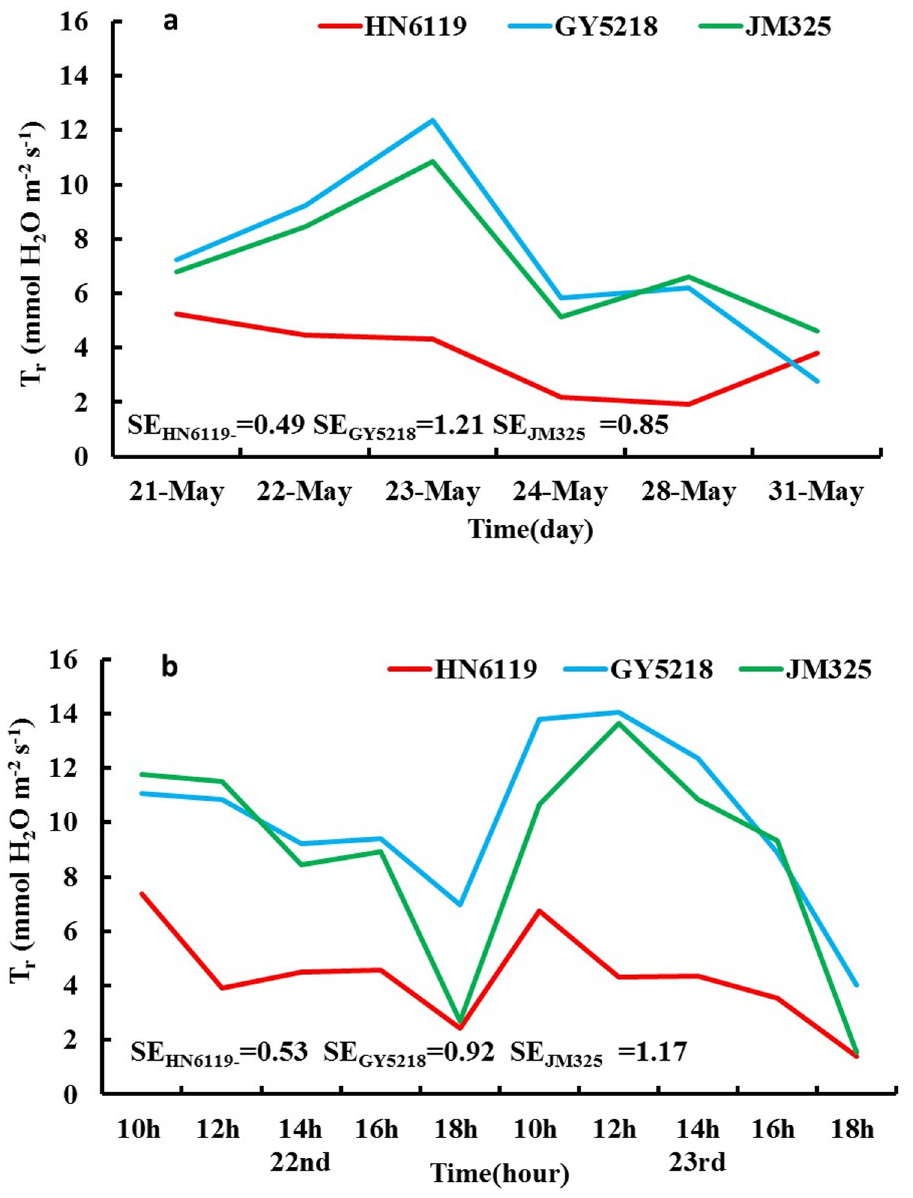
-2 s -1 ) from May 22 nd to 23 rd , 2019. (SE is the abbreviation of the standard error of T r (unit: mmol H 2 O m